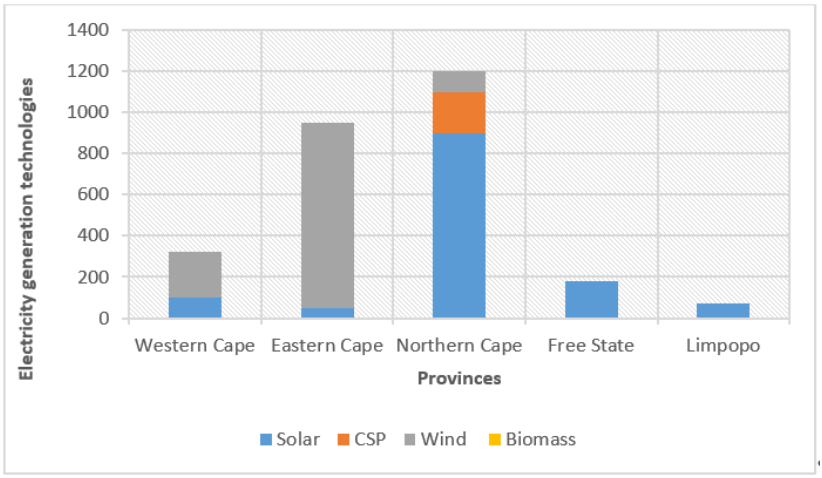
Figure 2. Eastern Cape electricity generation by different technologies compared to other provinces [4].